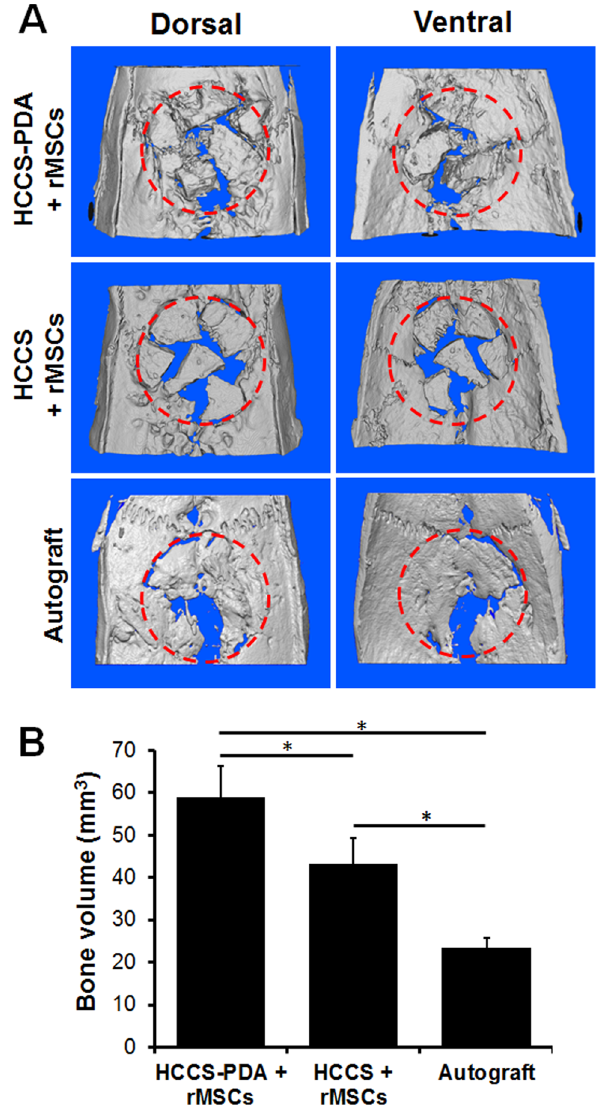
Figure 7. Micro-CT images of explanted critical sized calvarial defect after 12 weeks of implantation with HCCS-PDA with rMSC aggregates, HCCS with rMSC aggregates, and autograft ( A ). Red dotted circle: defect site (red dotted circle: 8 mm in diameter). Bone volume of the defect site including HCCS-PDA/HCCS and newly formed bone was quantified ( n = 4, * p < 0.05) ( B